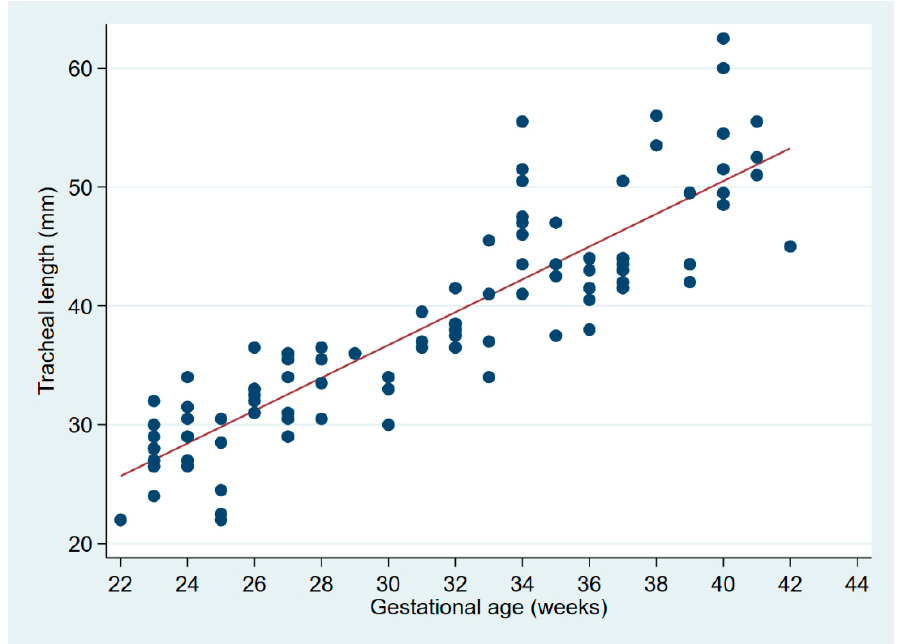
Figure 2. Linear regression of tracheal length on gestational age. The regression equation is: tracheal length (mm) = − 1.9 + 1.3 × GA (weeks), with r² = 0.7234 and p < 0.0001. TL related to weight is better fitted by a segmented regression with a node at weight = 1 kg (Figure 3 and Table 1).